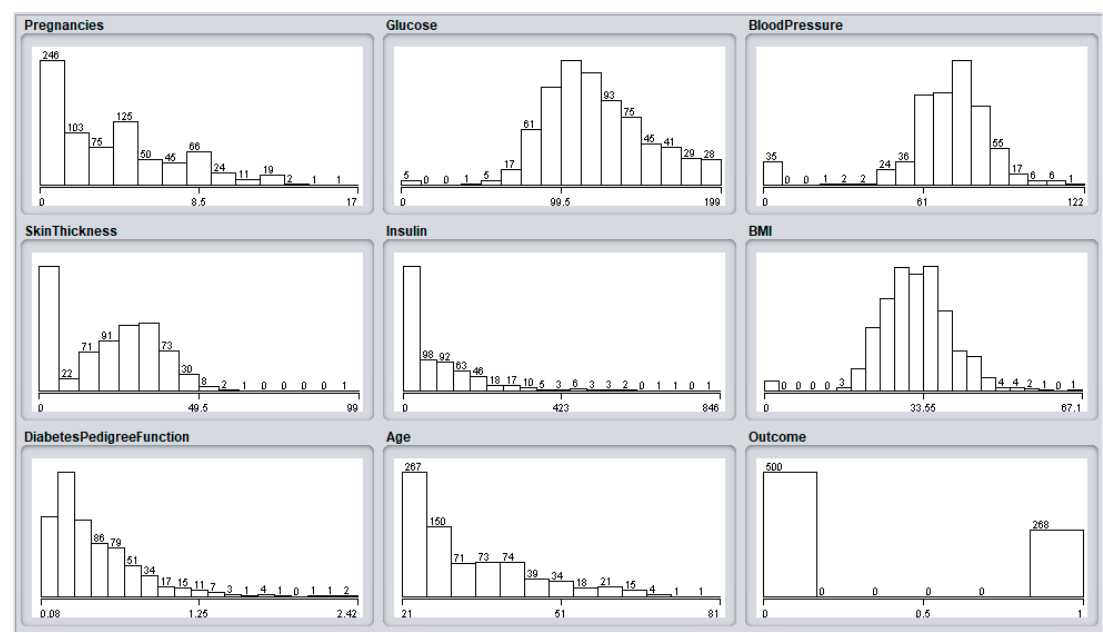
Figure 18. Data distribution for diabetes dataset attributes.